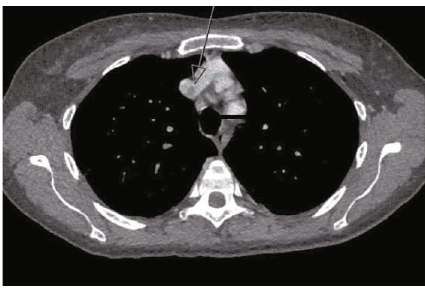
Figure 1: Axial computed tomography angiography depicting a fi lling defect (arrow) in the upper superior vena cava at the junction of the left and right brachiocephalic veins.